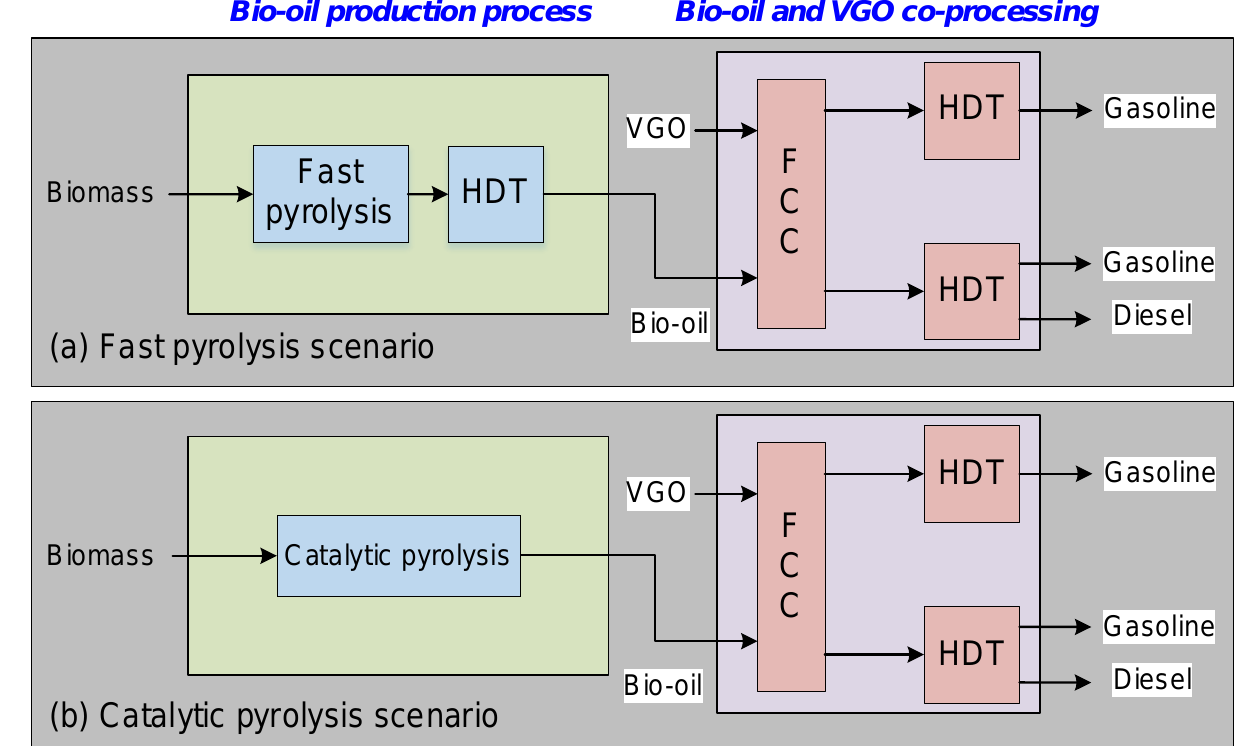
Figure 1. Process flowsheet of bio-oil co-processing with VGO.